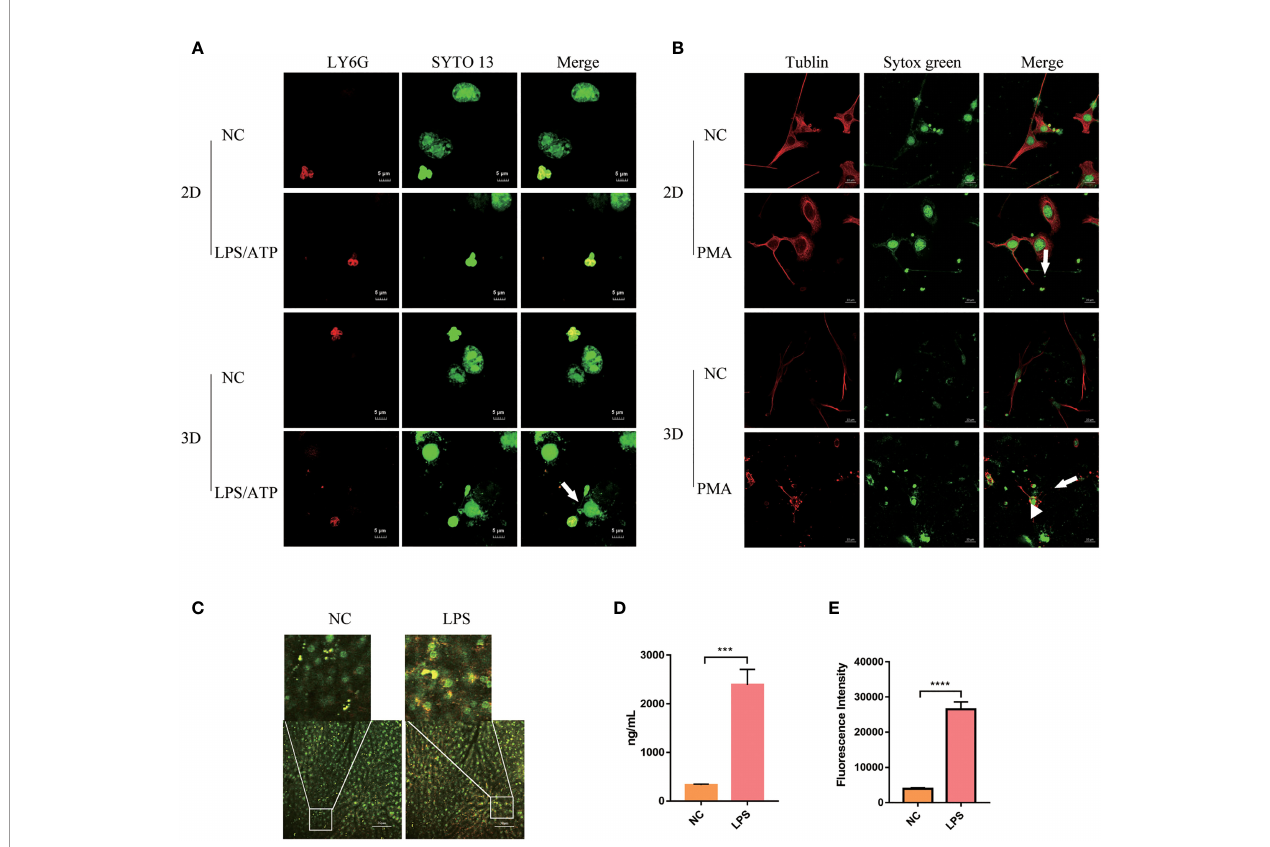
FIGURE 5 | Peripheral blood Neu co-cultured with parenchymal cells in 2D and 3D culture systems. (A) The formation of NETs (white arrow) of human peripheral blood Neu co-culture with NCM460 were observed under a confocal microscope. LY6G, PE (red) and nuclear, SYTO 13 (green). (B) The formation of NETs (white arrow) of Neu and blebbing (white arrowhead) of C2C12 were observed under a confocal microscope. Tublin, Alexa Fluor 594 dye (red) and nuclear, sytox green (green). (C) The formation of NETs (white box) produced by Neu in LPS-treated mouse was observed under a two-photon confocal microscope (APC-750-LY6G, red and nuclear-sytox green, green) in vivo . Quanti fi cation of NETs formation in the plasma was assessed by dsDNA (D) and neutrophil elastase coupled dsDNA (E) . Error bars represent mean ± S.D. n = 3, *** p < 0.001,**** p < 0.0001 by Two-way ANOVA. Each experiment was repeated three